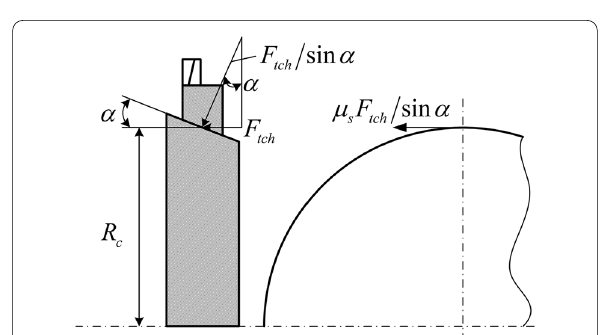
Figure 5 Dynamic model of